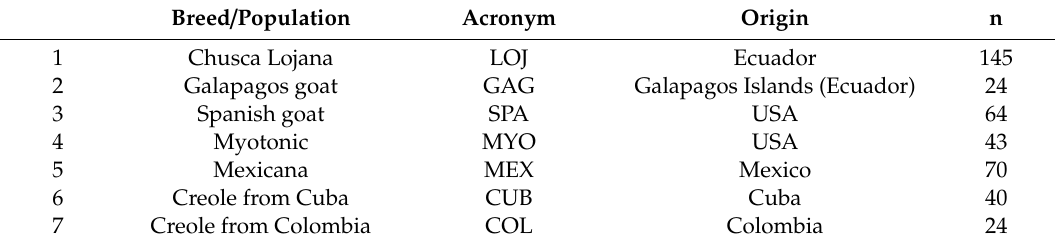
Table 1. Populations studied, acronym, origin, and number of samples analyzed for each population. Breed / Population